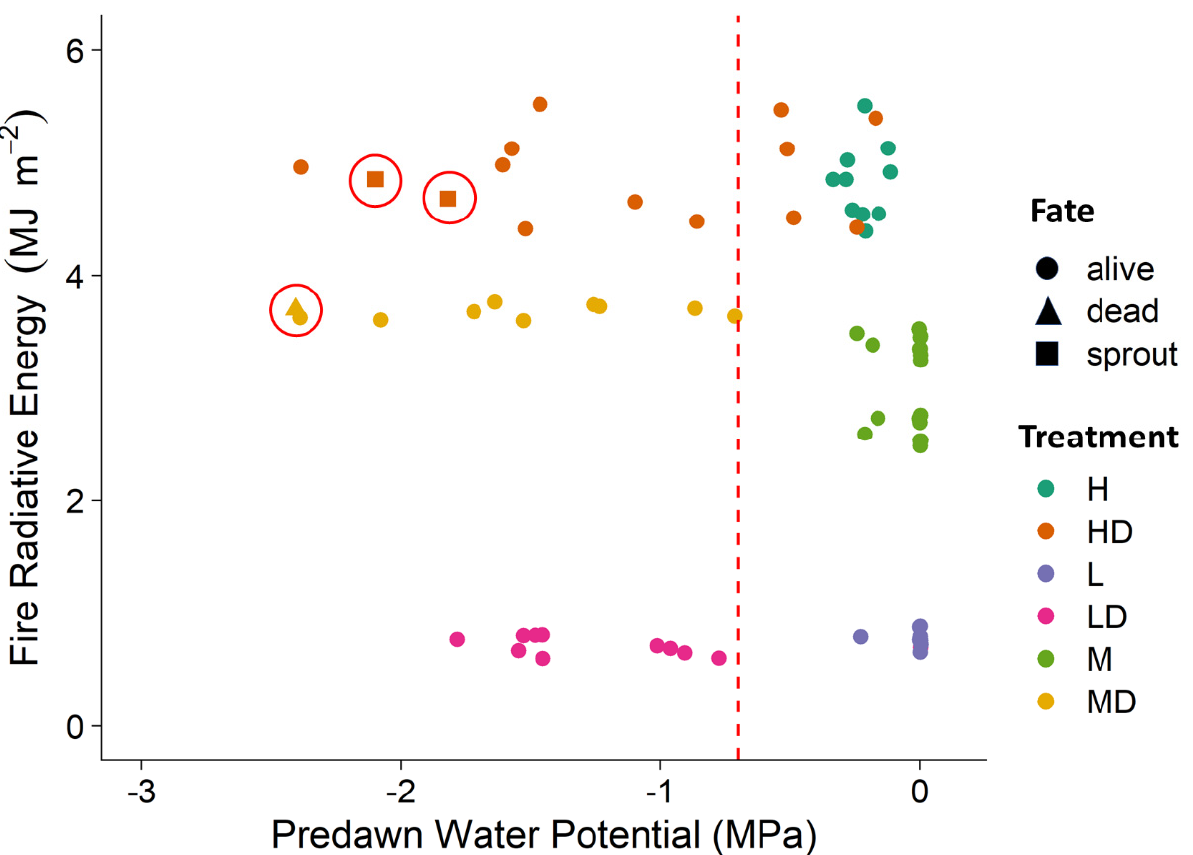
Figure 3. Pre-dawn water potential (MPa) and Fire Radiative Energy (FRE, MJ m − 2 ) at time of burn. Different colors represent each treatment group, and shape represents seedling fate. Points circled in red are those that either sprouted or died. Points with a water potential of 0 were not measured but plotted to show the distribution of FRE for the whole population of burned plants. Treatment acronyms are low fuel loading (L), low fuel loading + drought (LD), medium fuel loading (M), me- dium fuel loading + drought (MD), high fuel loading (H), high fuel loading + drought (HD). Vertical dashed red line is the point at which mid-day leaf level transpiration had stopped according to our dry down curve.